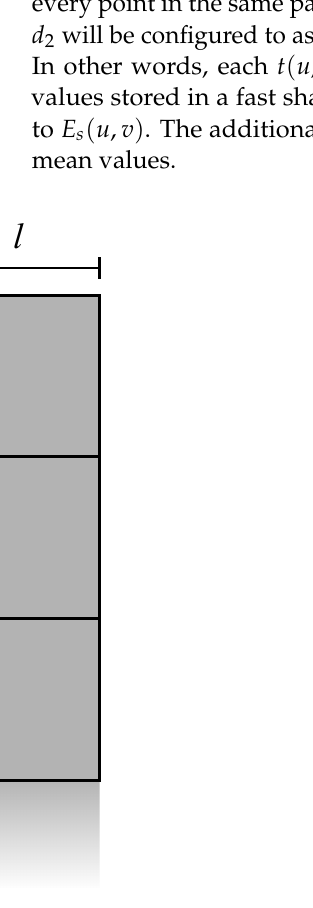
Figure 3. Splitting of input data into two vertical blocks copied on a zeroed larger array. if actor is the interpolation